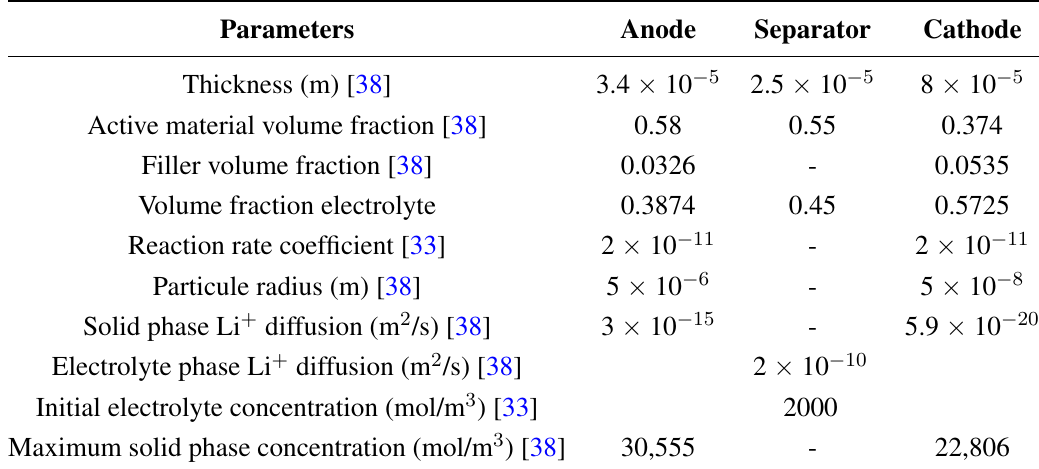
Table 2. Electrochemical parameters.